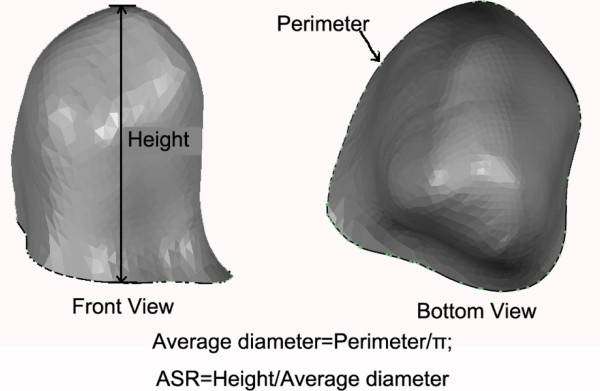
The definition of ASR (Aneurysm Size Ratio). The height is the perpendicular distance from the neck plane to the apex of the aneurysm sacculus, and the average diameter is computed from the perimeter of the aneurysm neck.